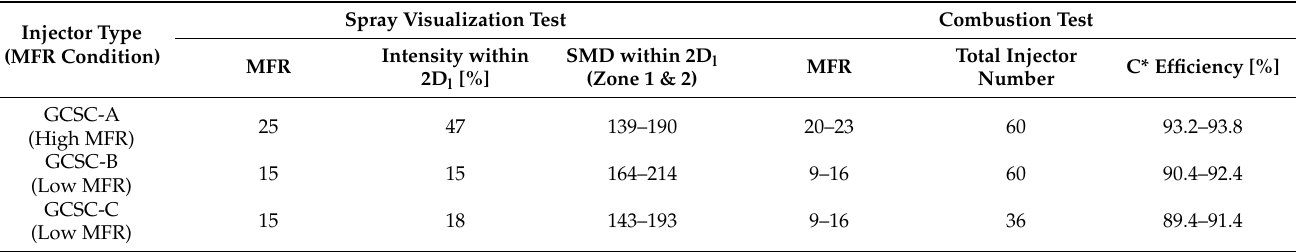
Table 3. Comparison of spray visualization test and combustion test results according to injec- tor